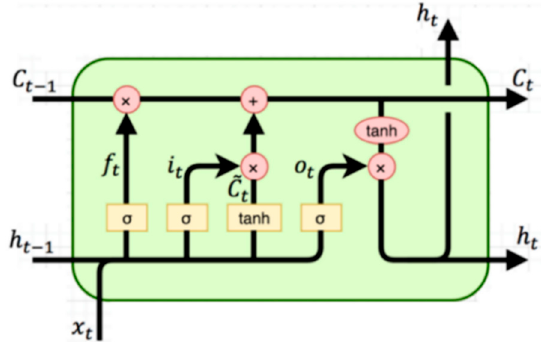
Figure 10. An LSTM unit. Reproduced from [17], MDPI: 2019.